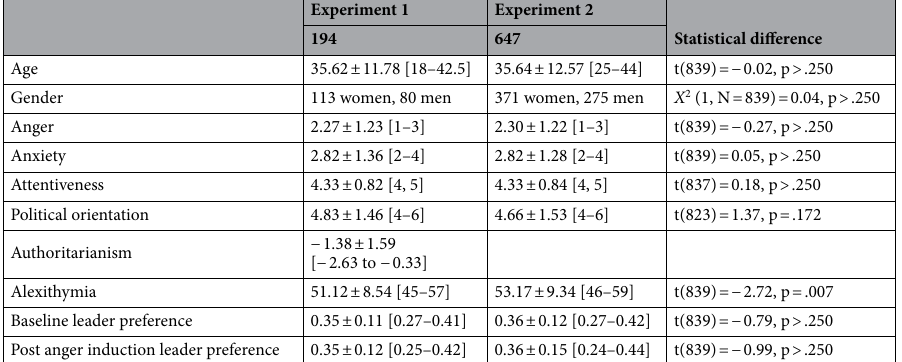
Table 1. Descriptive statistics of the participant samples of Experiments 1 and 2. Mean values are presented with the standard deviation and inter-quartile range [first quartile–third quartile]. T-values were obtained using Student’s